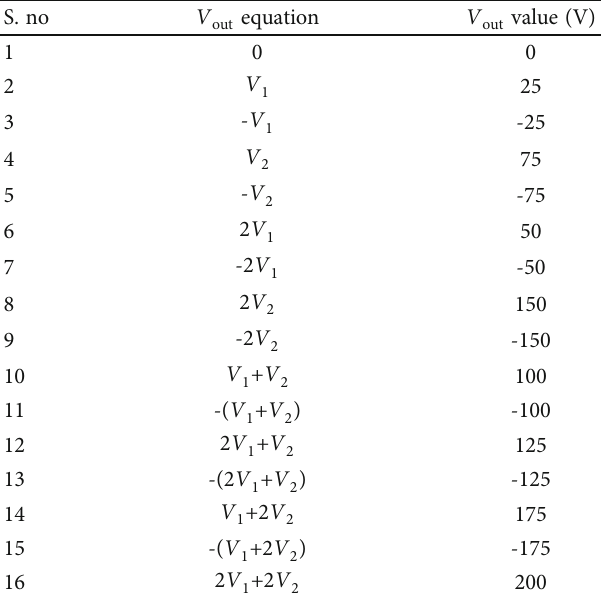
Table 4: Output voltage